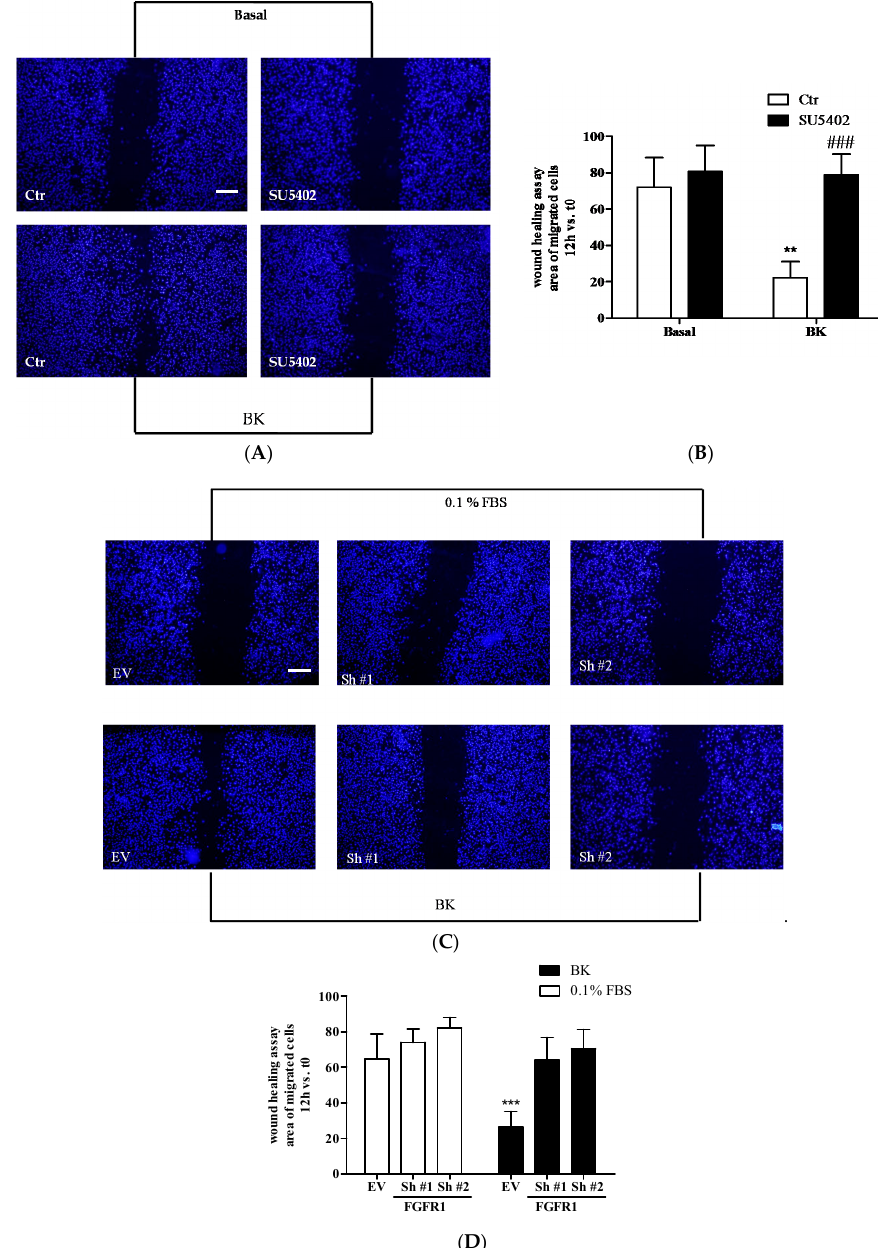
Figure 7. ( A , C ) Scratch wound healing assay on HUVEC treated with: in ( A ), 0.1% FBS (Basal, Ctr), BK (1 µM) (BK, Ctr), SU5402 (1 µM), SU5402 + BK; in ( C ), 0.1% FBS (EV), BK (1 μ M) (BK, EV), FGFR-1 knock down (0.1% FBS, Sh#1 and Sh#2), FGFR-1 knock-down + BK (BK, Sh#1 and Sh#2). ( B , D ) Quantification of cell migration was reported as the area of migrated cells. Figure B is the quantification of figure A and figure D is the quantification of figure C. ** p < 0.01 vs. Ctr cells; ### p < 0.001 vs. BK-treated cells. Numbers represent mean 3 ± SEM of three experiments run in triplicate. Bar = 100 µ